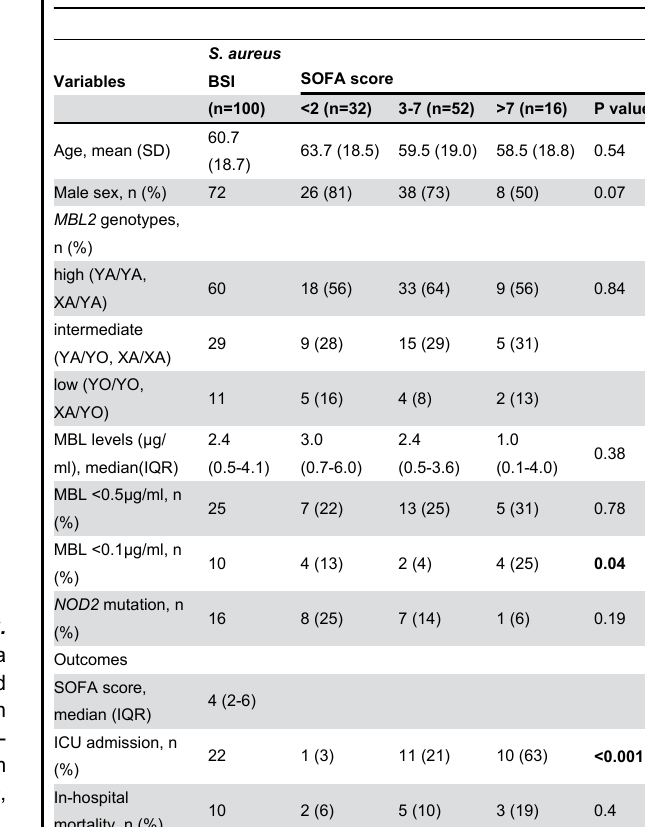
mannose-binding aureus ,